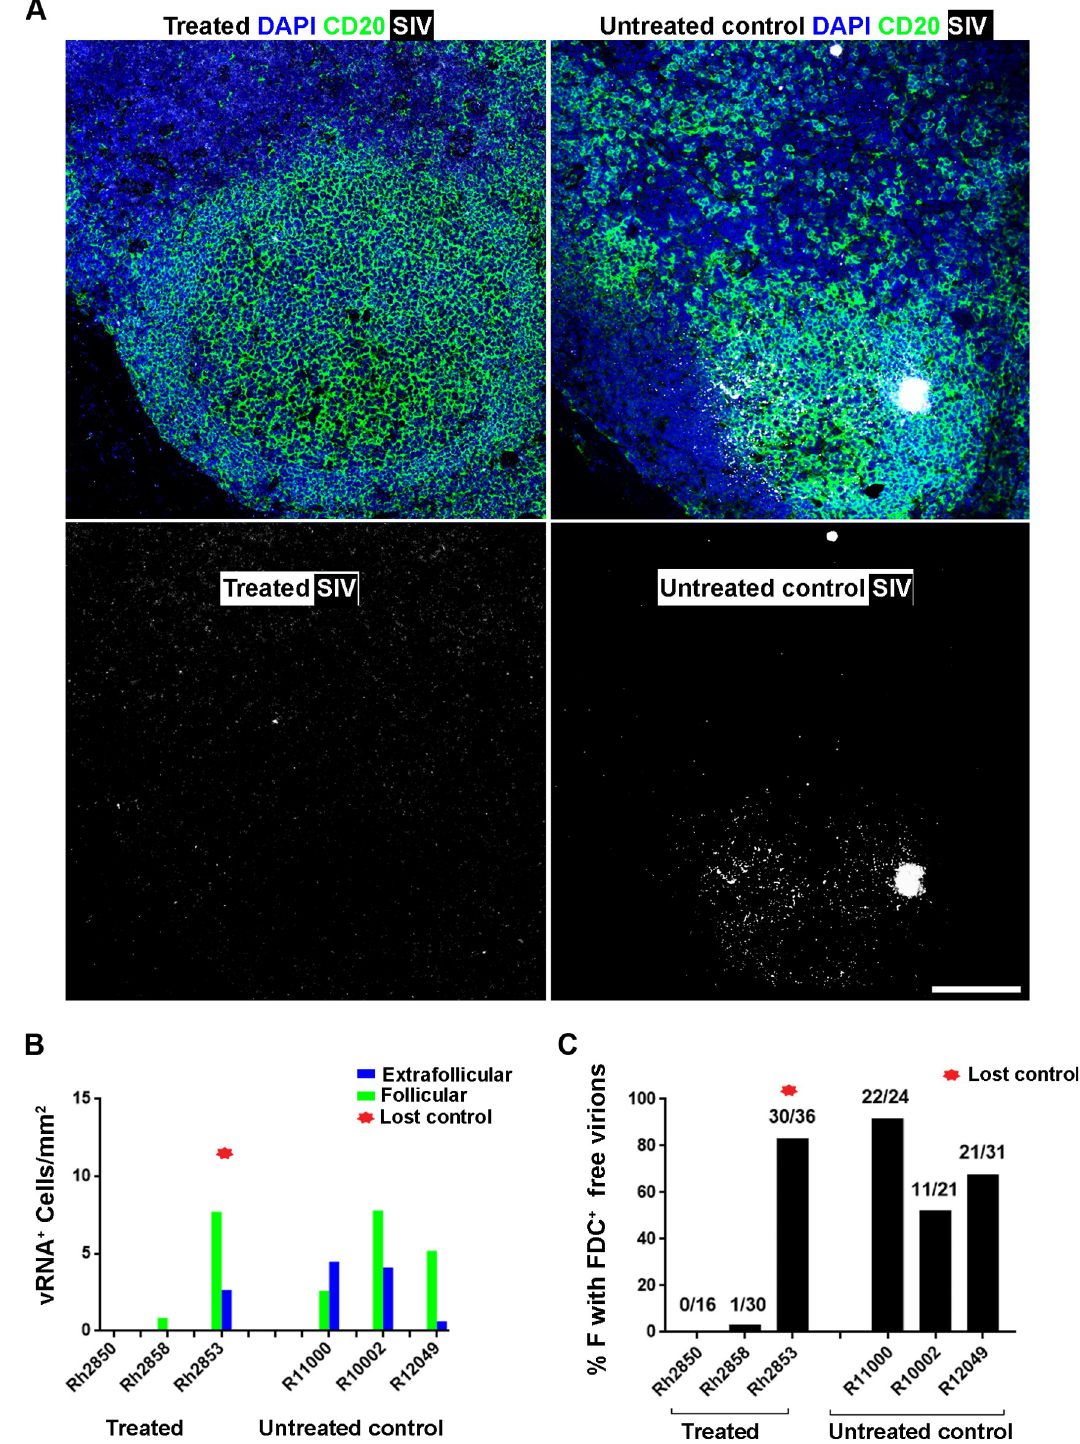
Fig 7. Infusion of CAR/CXCR5-T cells into SIV-infected rhesus macaques results in lower viral loads post-ART interruption. At 28 DPT, treated animals showed a reduction in viral (v)RNA compared to untreated control animals. (A) A representative image from a LN tissue section showing the abundance of SIV vRNA + cells and free virions trapped by follicular dendritic cells network (pseudo-colored white) detected using RNAscope ISH combined with IF in treated from Rh2850 (left panels) versus untreated control from R11002 (right panels). The tissue was stained with DAPI (blue), and anti-CD20 (green) to label B cells and delineate B